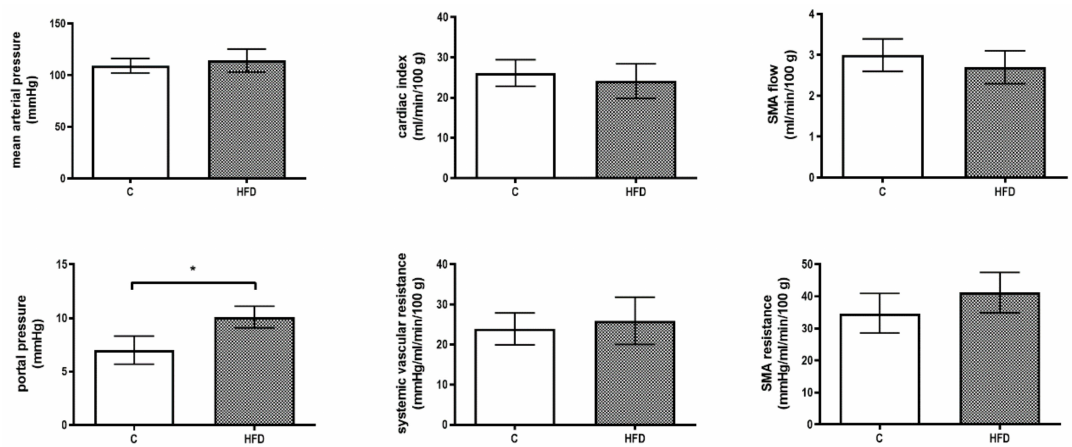
Figure 2. E ff ects of high fat diet (HFD) on hemodynamic parameters. Rats received regular chow diet (control, C) or HFD for 8 weeks. Portal pressure (PP) elevated significantly in HFD group. There was no significant di ff erence in mean arterial pressure (MAP), cardiac index (CI), systemic vascular resistance (SVR), superior mesenteric artery (SMA) flow and resistance (* p < 0.05).